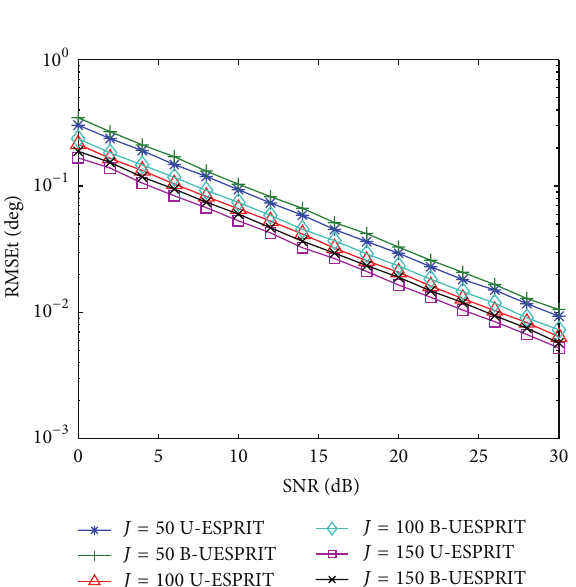
Figure 6: RMSE of DOD versus SNR for 3 sources with different values of